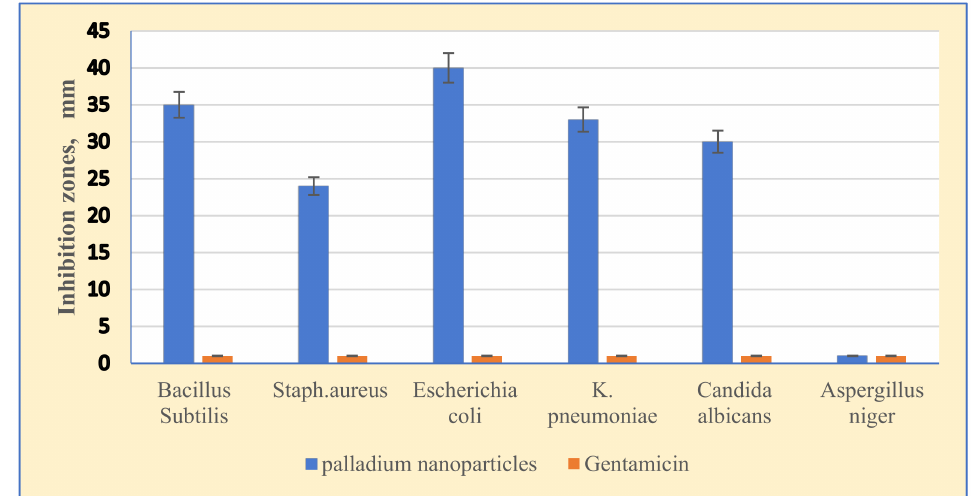
Figure 12. Inhibitory effect of biosynthesized palladium nanoparticles using Saudi propolis on different microbes (inhibition zones in